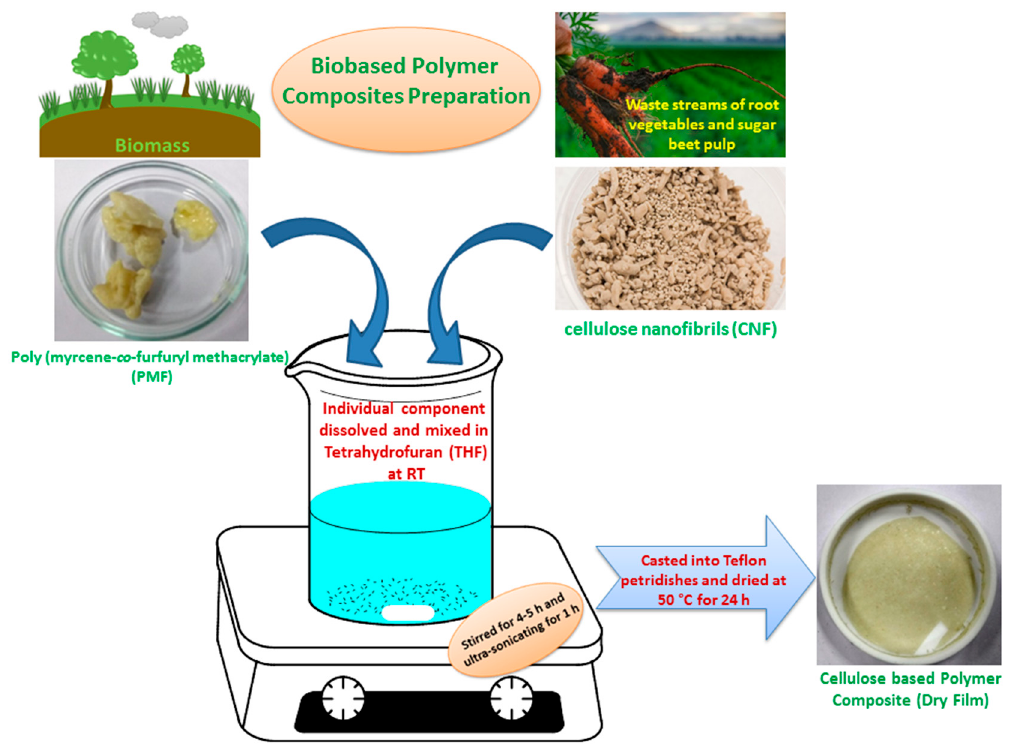
Figure 2. Schematic diagram for the preparation of biobased poly (myrcene- co -furfuryl methacrylate)/cellulose nanofibrils (PMF/CNFs) composites.